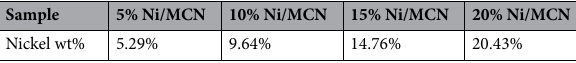
Table 2. Elemental